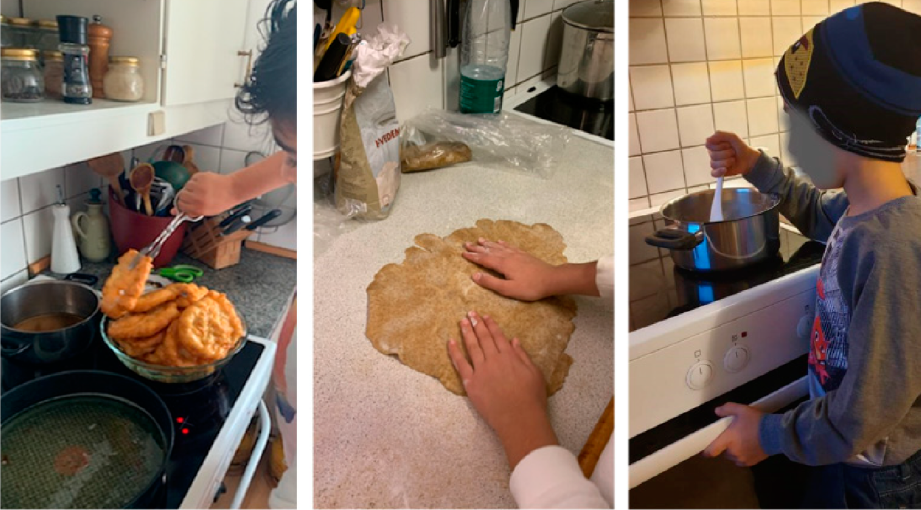
Figure 2. Children cooking at home together with their parents (photos sent by families between the cooking